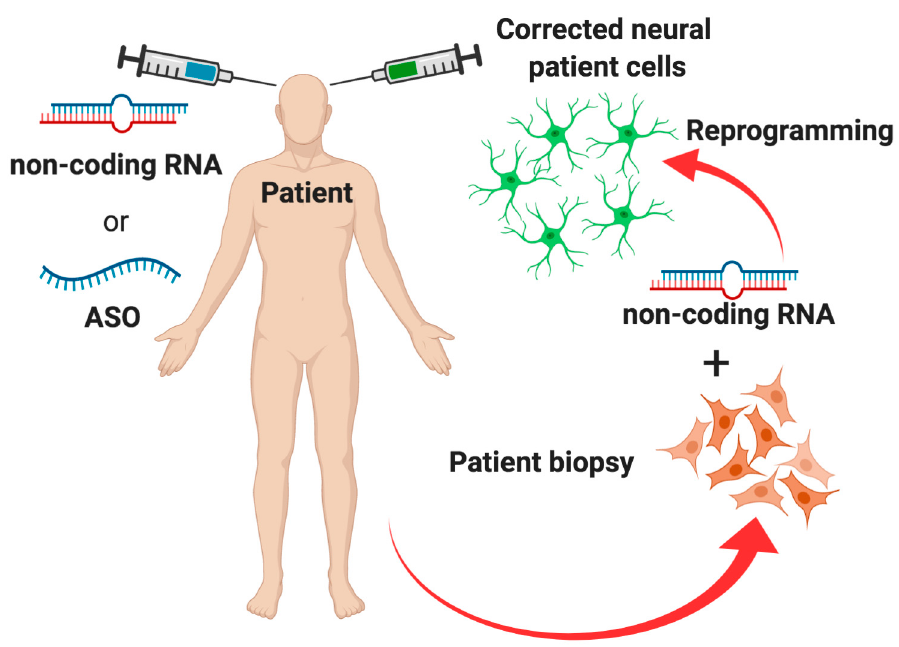
Figure 3. RNA therapeutics approach for neurodegenerative disease. The picture shows an ideal representation of potential RNA therapeutics approaches in which noncoding RNAs (ncRNAs) or antisense oligonucleotides (ASOs) are used to modulate genes involved in neurodegeneration. On the right side of the picture is a potential use of ncRNAs to reprogram and correct patient somatic cells. Red cells indicate diseased cells derived from a neurodegenerative disease patient, whereas green cells represent cells corrected with ncRNAs and reprogrammed towards neural phenotype. On the left side of the picture is a potential direct in vivo reprogramming/correction approach of resident neural cells.